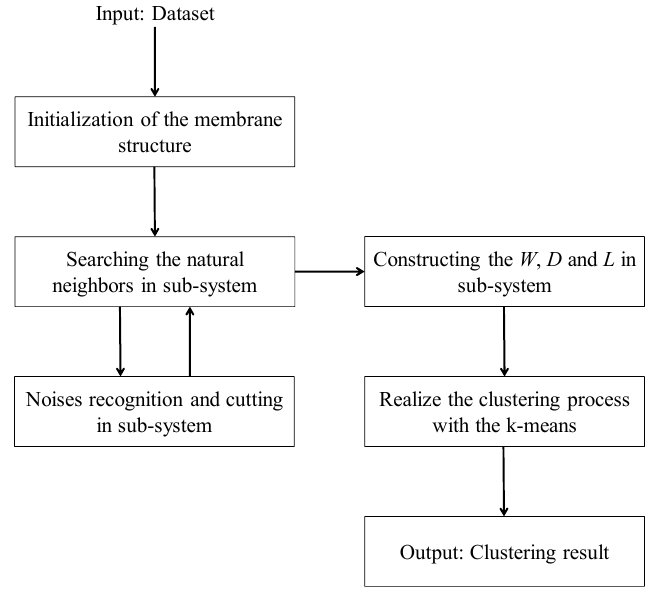
Figure 3 The flow chart of the proposed NCNNSC-CP algorithm. Figure 3. The flow chart of the proposed NCNNSC-CP